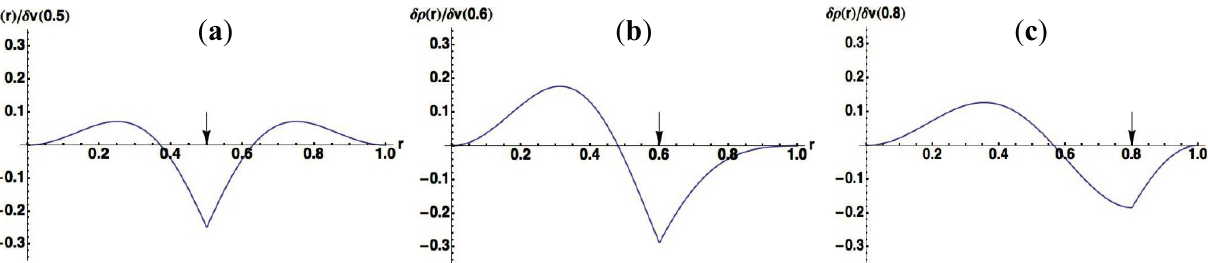
Figure 2. Plots of dr(r)/dv(r ′ ) where virtual perturbations are applied to specific points (r ′ ) indicated by arrows for the Nocc = 1 case. ( a ) r ′ = 0.5; ( b ) r ′ = 0.6; ( c ) r ′ = 0.8.